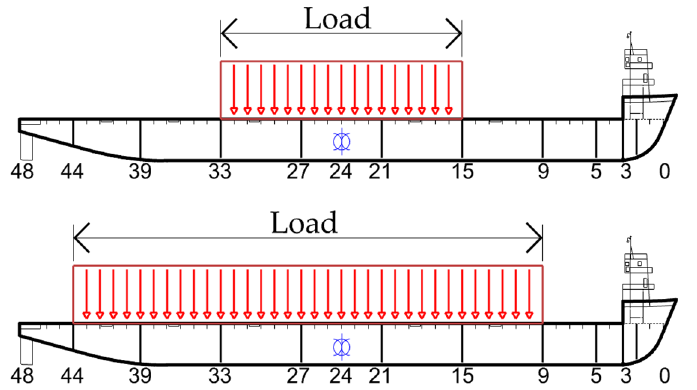
Figure 4. Schematic view of two cargo distributions of 7000 tons each one on the barge deck.